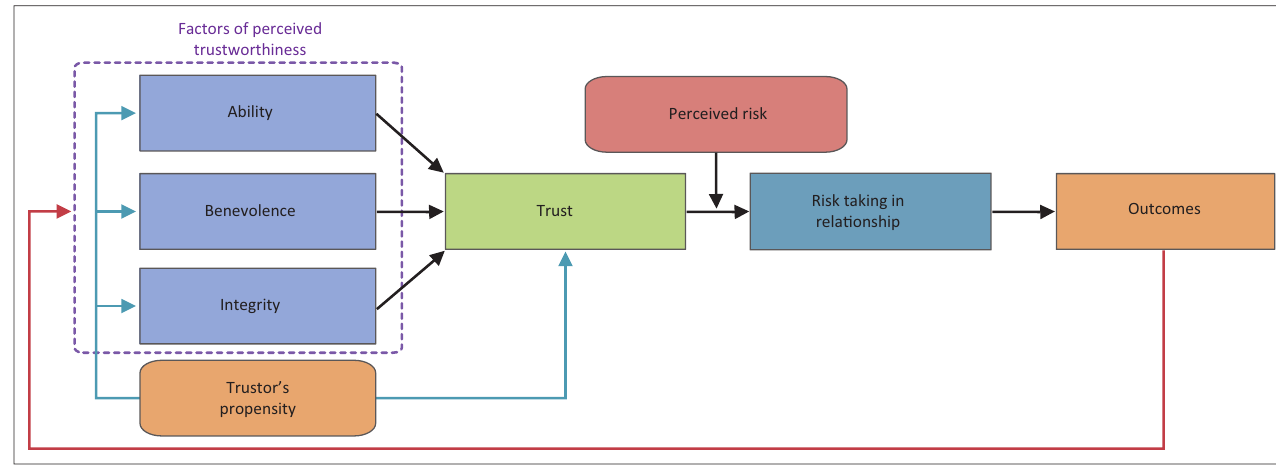
FIGURE 1: Integrated model of interpersonal